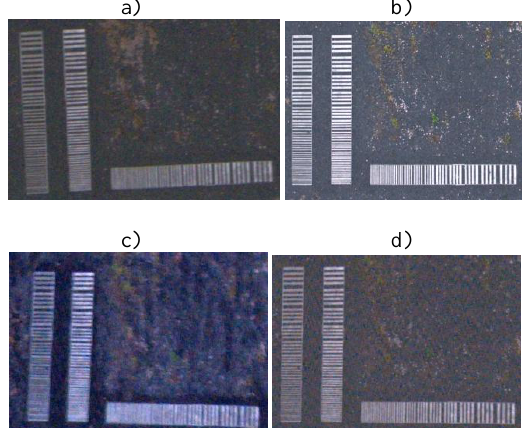
Figure 4. Examples of image quality with different sensors and